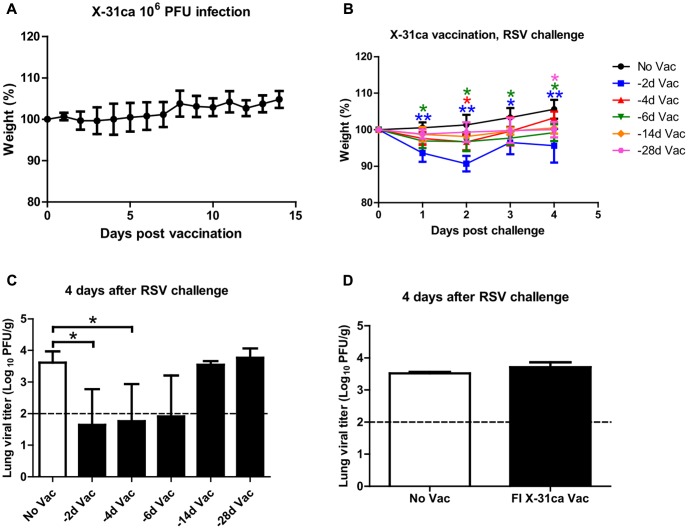
Safety and protective efficacy of X-31ca against RSV challenge. (A) Mice (n = 4 per group) were vaccinated with 106 PFU of X-31ca and weight changes were observed daily for 2 weeks. (B,C) Mice (n = 4 per group) were vaccinated with 106 PFU of X-31ca and RSV A2 at 2 (–2d Vac), 4 (–4d Vac), 6 (–6d Vac), 14 (–14d Vac), or 28 (–28d Vac) day intervals. Non-vaccinated (No Vac) mice were infected with 106 PFU of RSV A2 only. The body weight was monitored daily (B) and lung viral titer was determined by plaque assay at day 4 p.c. (C). (D) Mice (n = 4 per group) were vaccinated with formalin-inactivated X-31ca and challenged with 106 PFU of RSV A2 2 days later (FI X-31ca Vac). Non-vaccinated mice were infected with 106 PFU of RSV A2 only (No Vac). Lung viral titer was determined by plaque assay at day 4 p.c. The dotted line represents the limit of detection; 100 PFU/g of lung tissue (∗P < 0.05, ∗∗P < 0.01 compared with the No Vac control group).